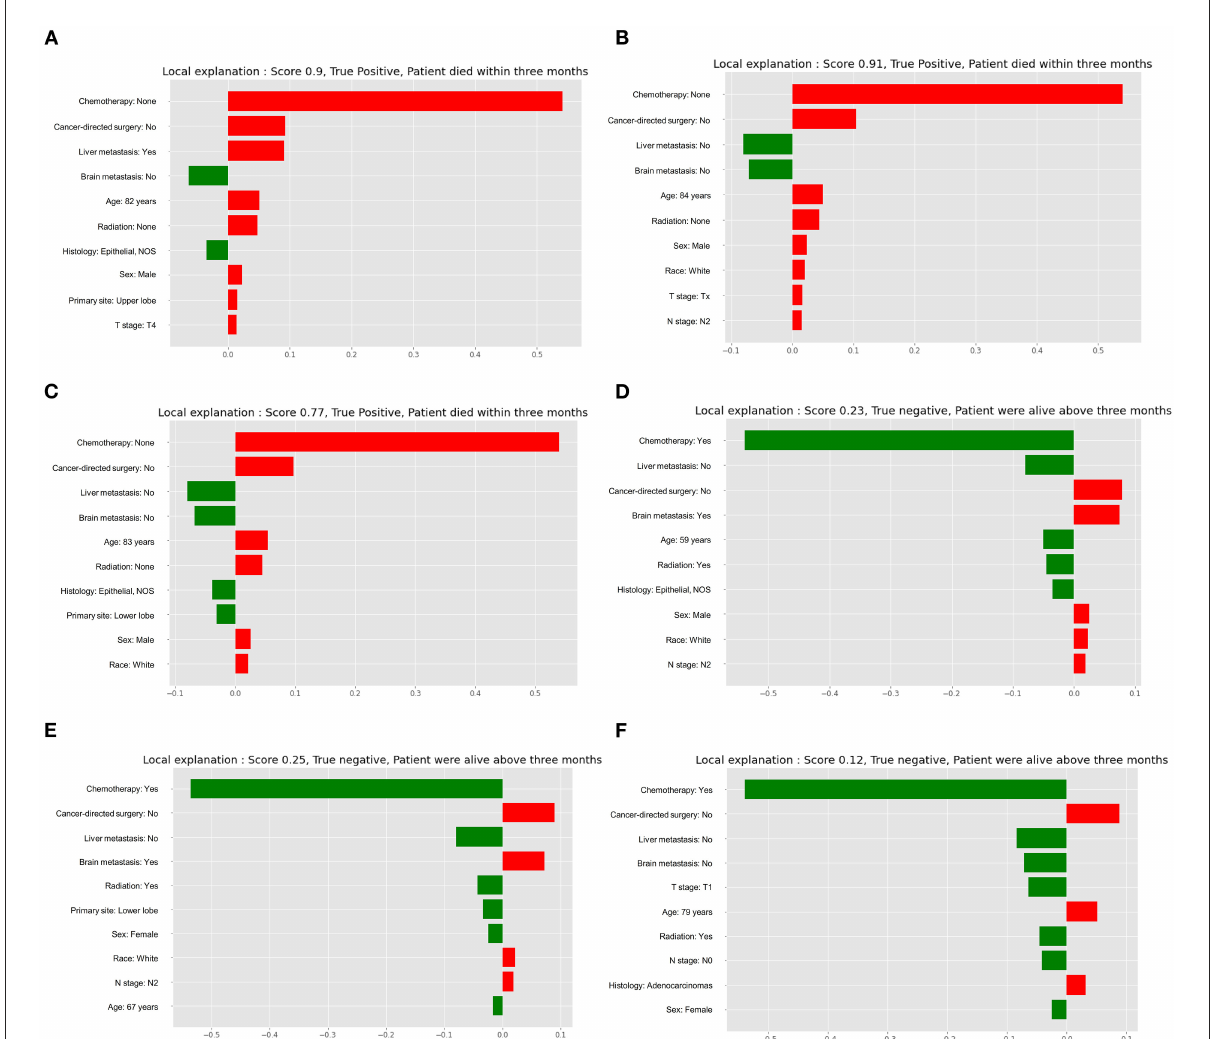
FIGURE5 Local interpretable model explainer for six individual cases. (A) The first true positive case; (B) The second true positive case; (C) The third true positive case; (D) The first true negative case; (E) The second true negative case; (F) The third true negative case. Features with a green bar indicates protective prognostic factors, and those with red bar represents contributing risk factors. The x-axis depicts how much each predictor added or subtracted to the final probability for the specific patient.